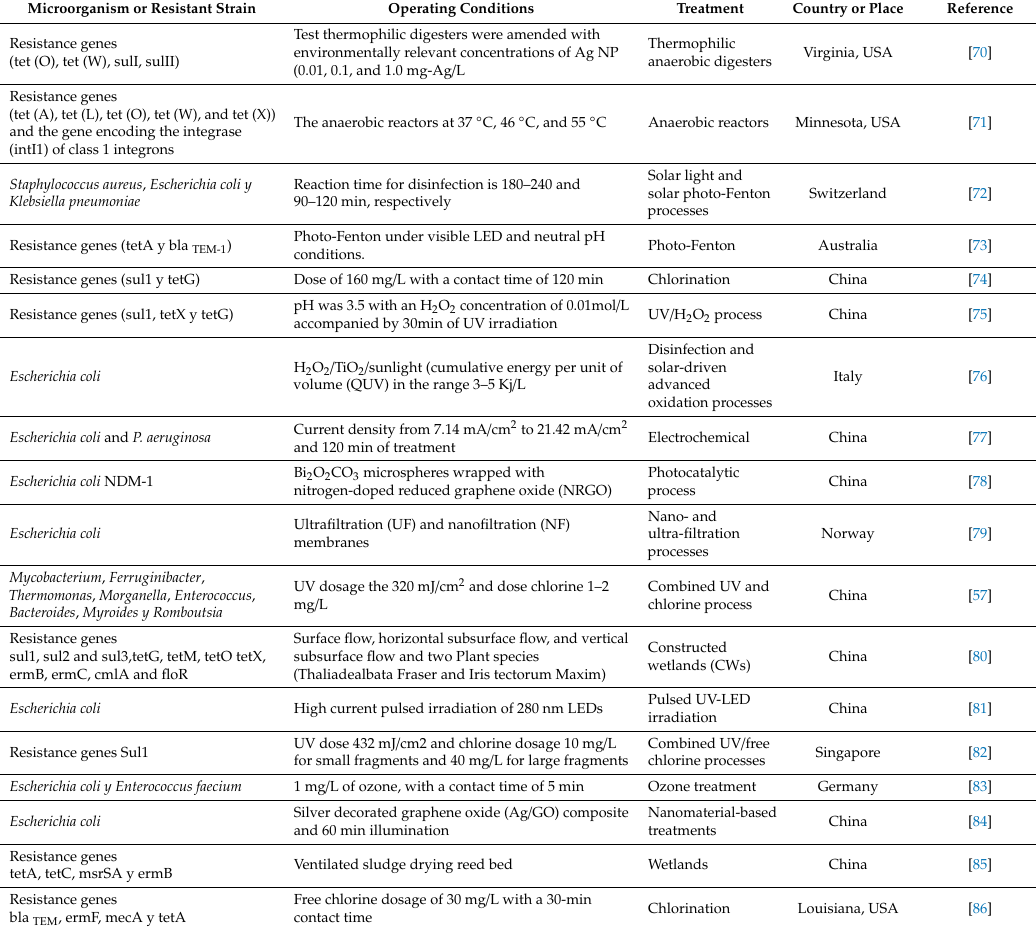
Table 3. Examples of technologies treatment for antimicrobial resistance